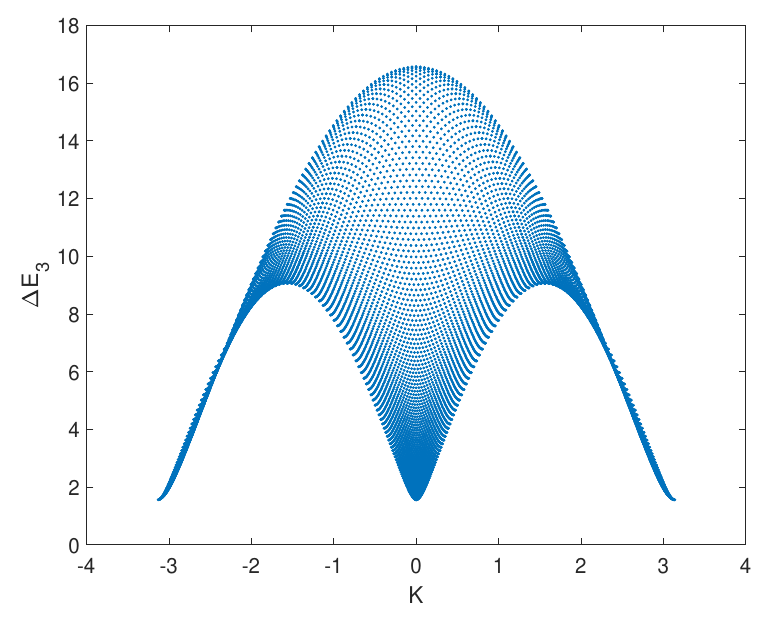
Figure 8 . The dispersion relation of a single excitation for η = 1 . 31696 + iπ